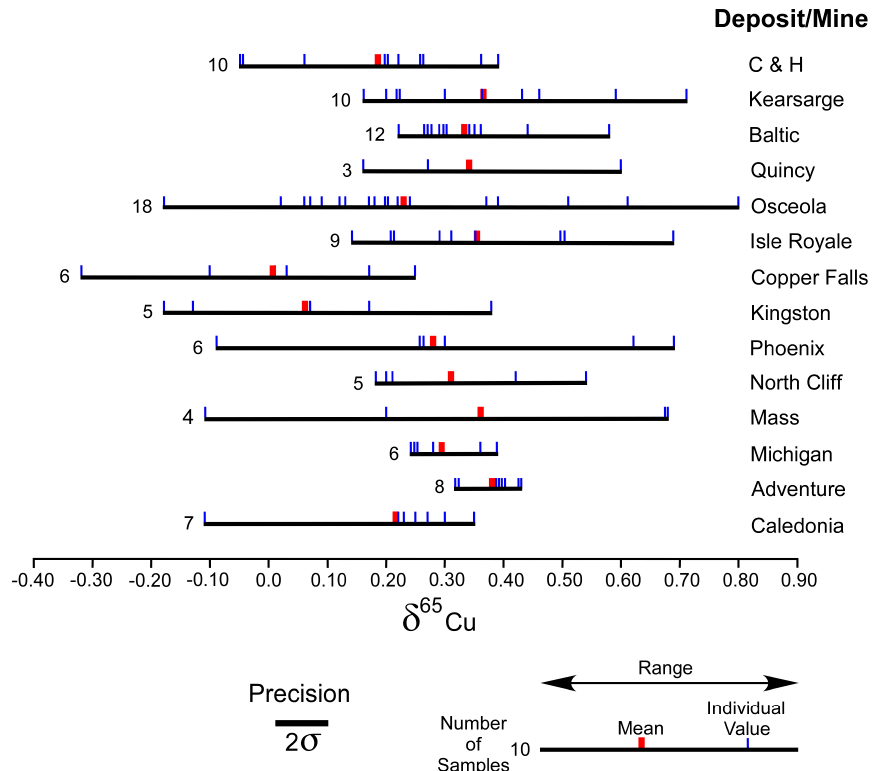
Figure 5. Graphical comparison of the mean and range of the copper isotopic composition of deposits/mines of the Keweenaw Peninsula native copper district when the number of samples is three or more. Deposits are ordered by production size with the largest at top as given in Table 1. Copper isotopic data are given in Table 2. Individual values are slightly adjusted so all values are observable.